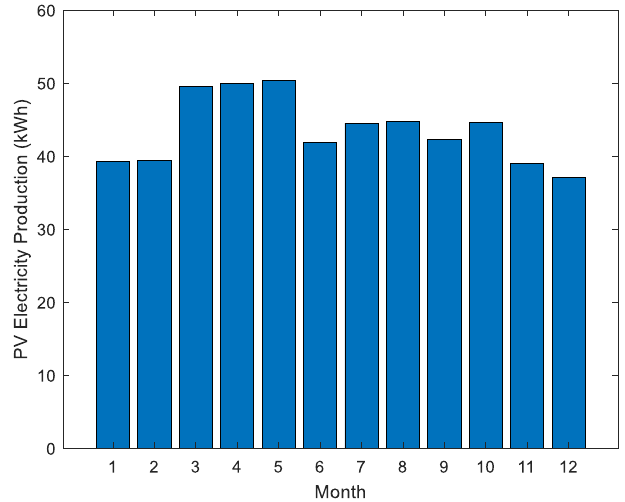
Figure 6. Summation of monthly energy produced by a PV panel.